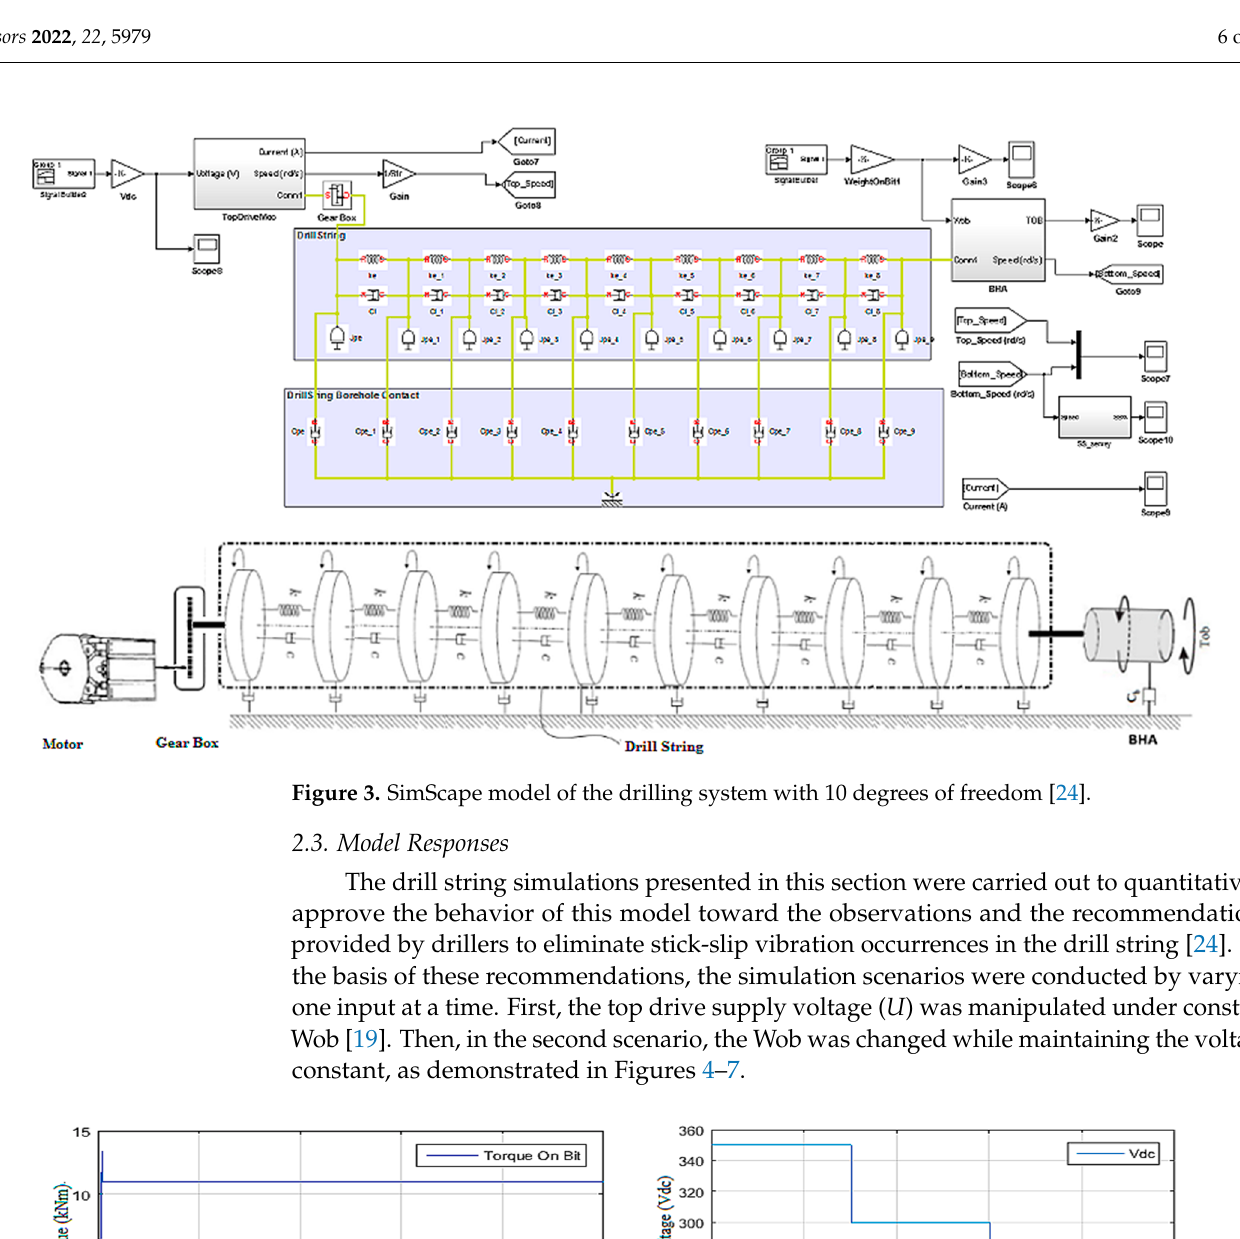
Figure 3. SimScape model of the drilling system with 10 degrees of freedom [24].